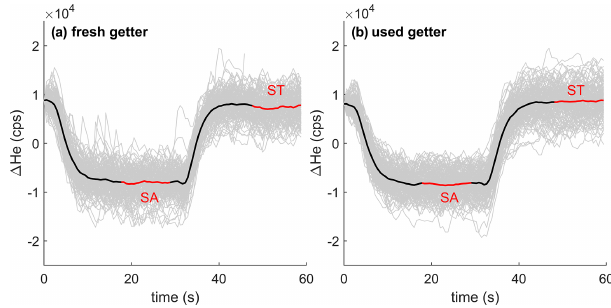
Figure 5. Stack of 4 He ion count difference (10 4 counts per sec- ond, cps) when switching between the same standard (ST) and sam- ple (SA) gas stream using fresh titanium sponge (a) and nearly de- pleted getter material (b) . Gray lines show individual records forced to align at time equals zero, and the thick black line shows the av- erage of all stacked switching events. The analysis cycle consists of (i) switching to SA with an idle time of ∼ 18s, (ii) a ∼ 12s integra- tion of ions from SA, (iii) switching back to ST, again with a ∼ 18s idle time, and finally (iiii) a ∼ 12s integration of ST.